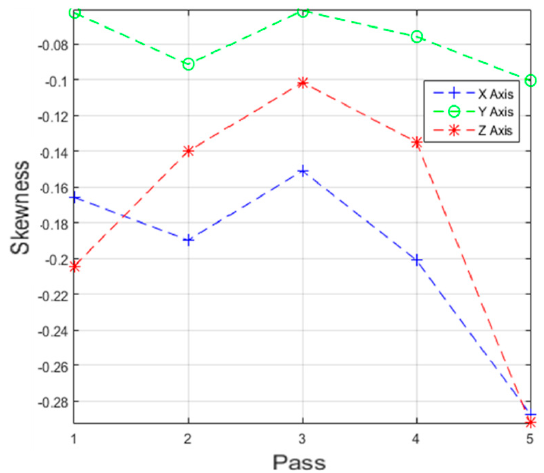
Figure 10. Skewness vs. number of passes.